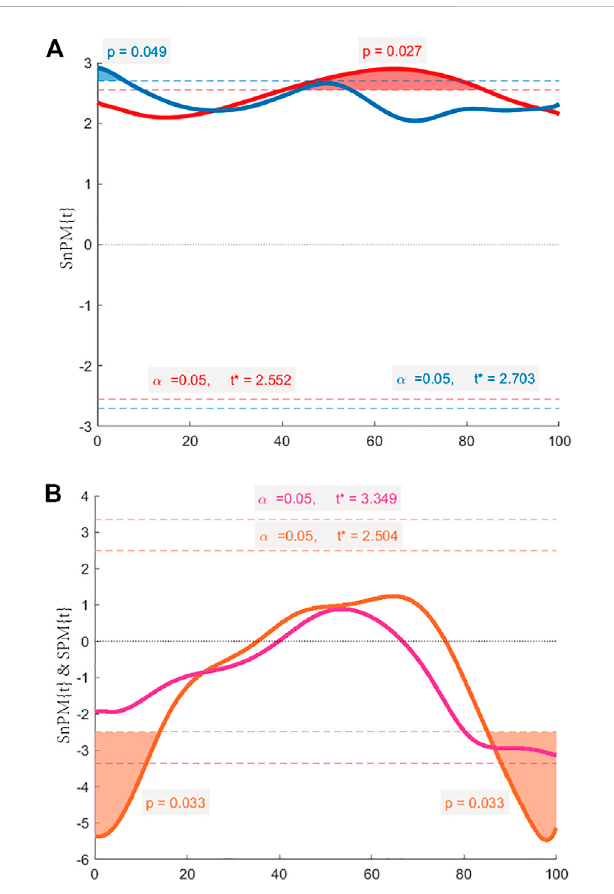
FIGURE 5 The SPM{t} & SnPM{t} curves. The shaded areas on the curve show the track locations where the curve exceeded the critical threshold (dotted line). When the observed t-statistic time series crosses the threshold, which means p < 0.05, then we can reject the null hypothesis H0 that there is no difference between the two time series. (A) Comparison between healthy hips and affected hips during normal walking by SPM (red line), and during long stride walking by SPM (blue line). (B) Comparison between normal and long stride walking in healthy hips by SnPM (orange line), and in affected hips by SPM (purple